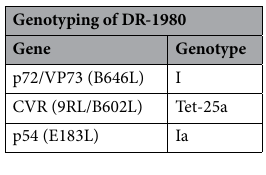
Table 1. Genotyping of